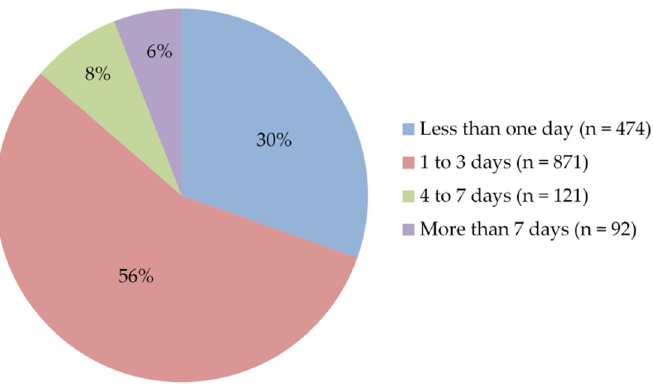
Figure 8. Participants’ answers to the question “How long did the post-vaccination side effects last?”